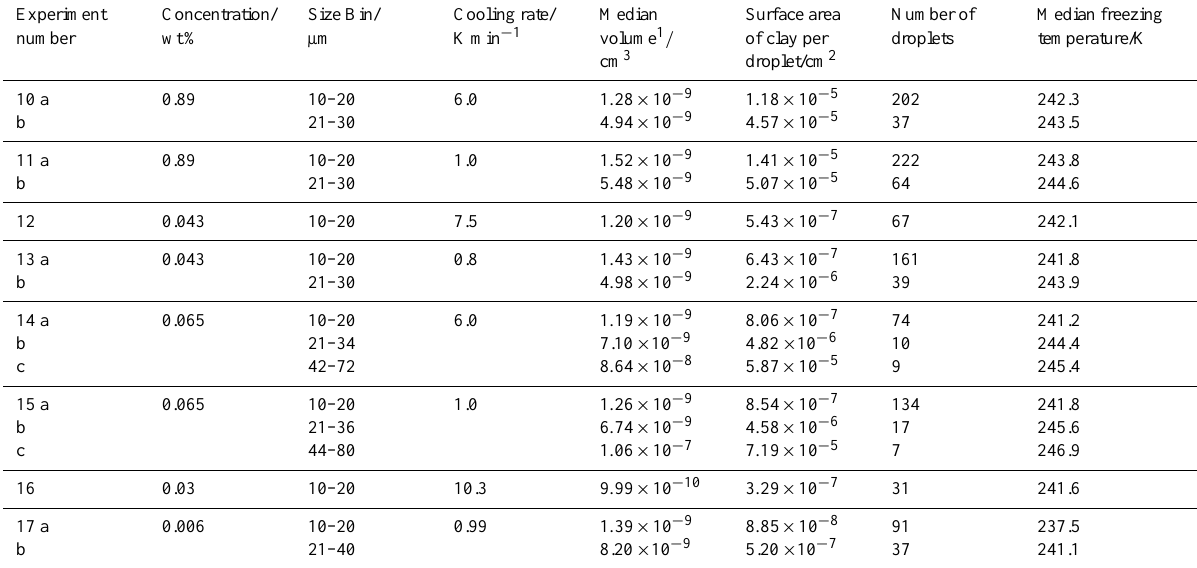
Table 3. Summary of experimental conditions for runs performed using a cooling rate other than 5Kmin − 1 . Droplet distributions were split into size bins, which are labelled a, b and c. The median freezing temperatures for each run are also presented.